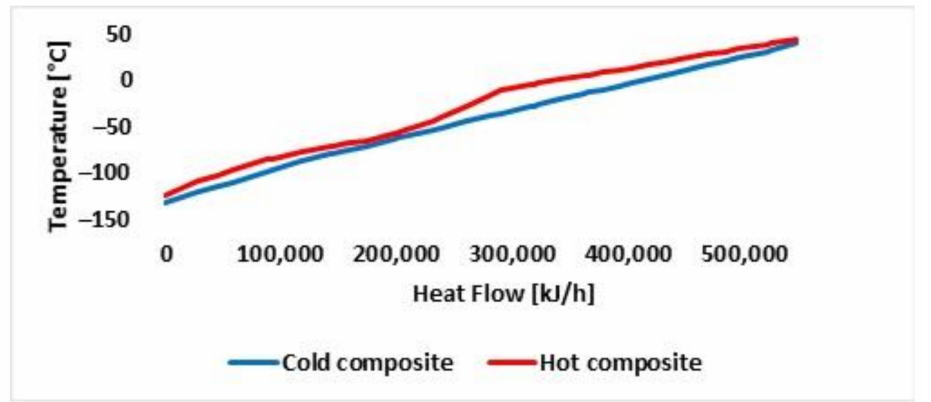
Figure 12. Heat transfer composite curves for DE Cold-Box.